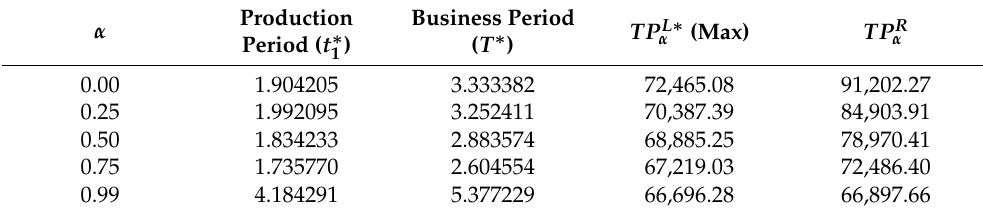
Table 14. Optimum results of Example 5 for maximizing TP L α .